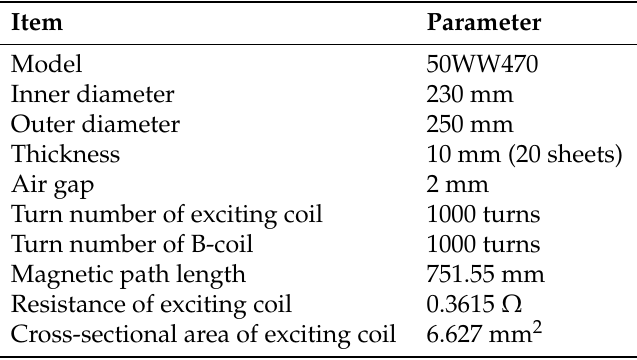
Table 1. Parameters of the